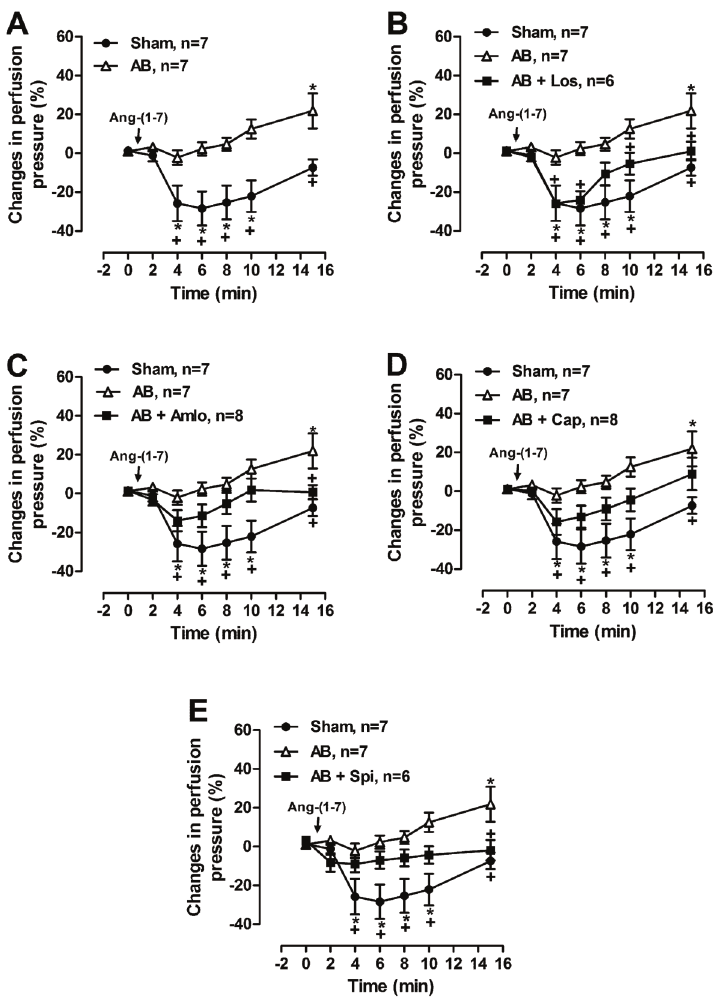
Figure 4. Effects of Ang-(1-7) (2 (cid:3) 10 – 11 M) on coronary perfusion pressure in isolated perfused hearts from rats that underwent aortic banding (AB) and were ( A ) untreated or chronically treat- ed with ( B ) losartan, ( C ) amlodipine, ( D ) capto- pril, or ( E ) spironolactone (5 mg (cid:1) kg – 1 (cid:1) day – 1 ). Data are reported as means ± SE. Los: losartan; Amlo: amlodipine; Cap: captopril; Spi: spirono- lactone. *P o 0.05 compared with basal levels; + P o 0.05 between time points (two-way ANOVA followed by Dunnett ’ s to compare to basal levels; Sidak multiple comparison post-test to compare between time